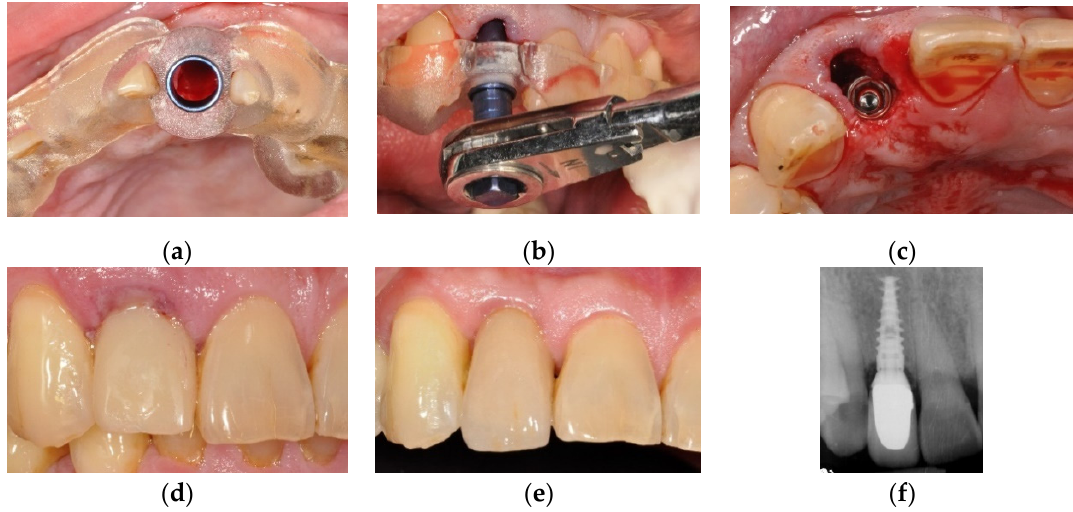
Figure 3. Clinical procedures of the patient in Figure 1. ( a ) The surgical guide was checked for correct seating. ( b ) Fully guided implant placement through the surgical guide. ( c ) The implant was inserted at the planned position. ( d ) Provisional crown in place the subsequent day after surgery. ( e ) Finished crown restoration after 6 months of healing. ( f ) Radiograph of the finished restoration.